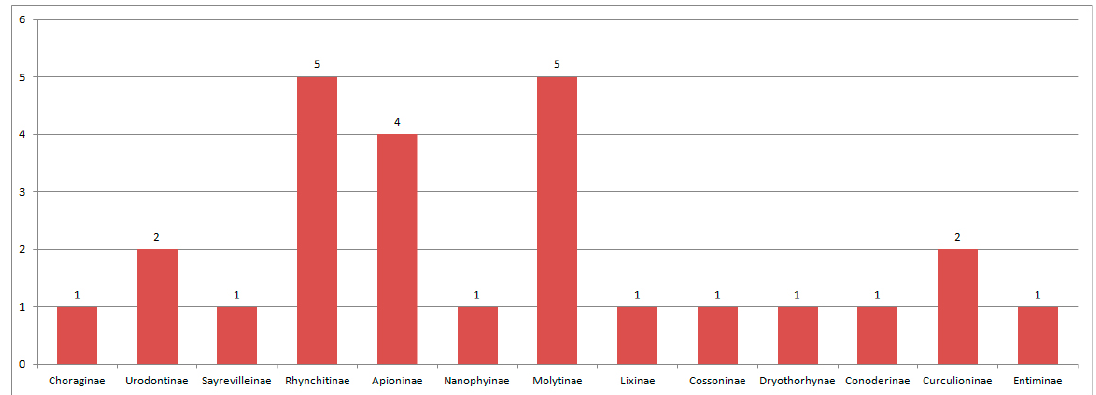
Figure 25. Composition of species of Curculionoidea in Rott.